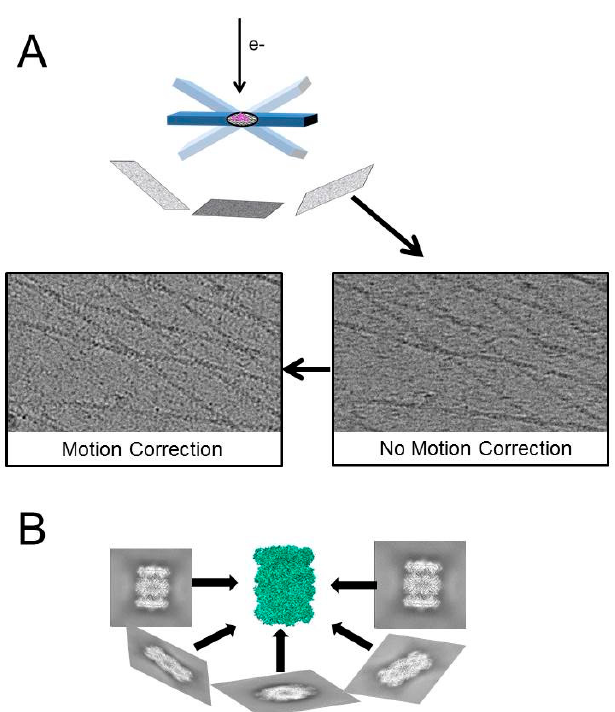
Figure 2. General principles in the generation of electron tomograms. ( A ) Collection of movies at different sample tilt angles. The movies are motion corrected and electron dose weighted. The left box shows the sum of the individual movie frames. Only movement correction reveals fine features of the sample (right box). ( B ) Corrected projection images of the sample with known angles yield a structure of the imaged object.